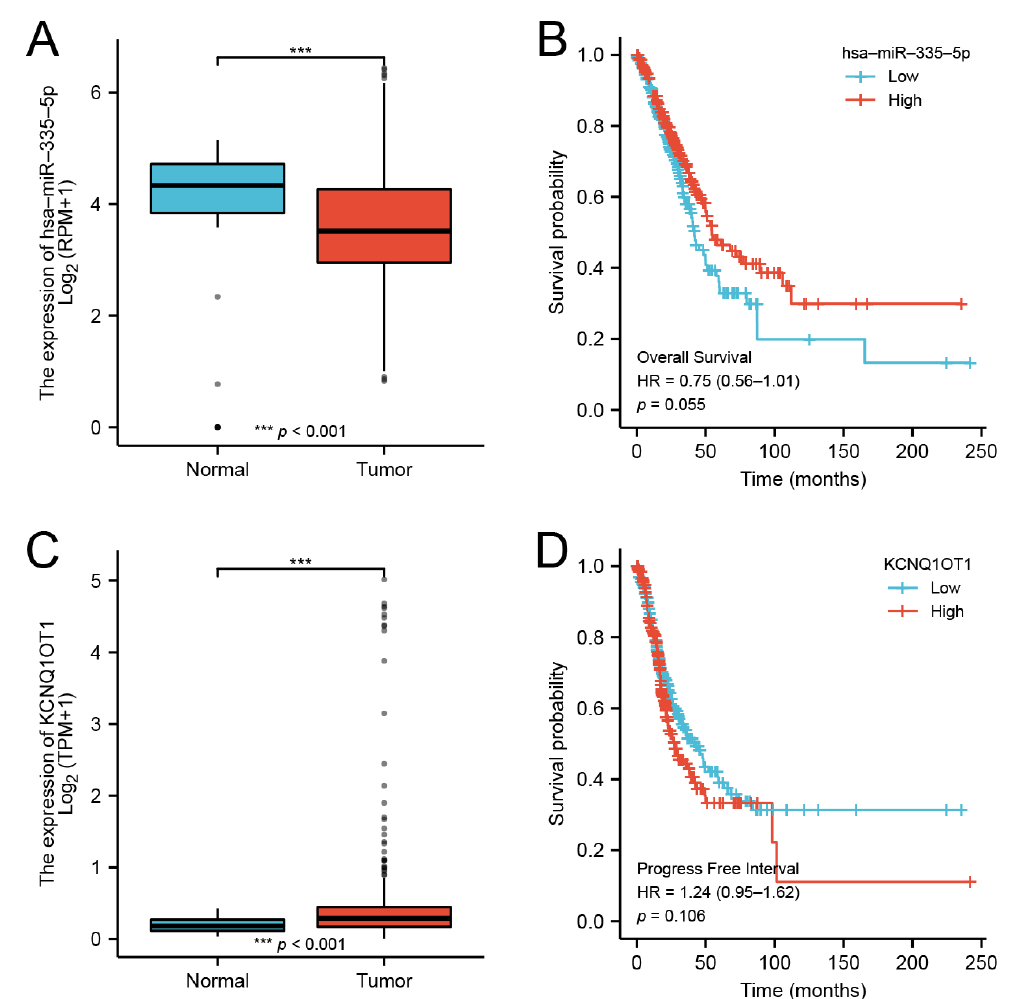
Figure 11. Expression and prognosis of the DMRT3 ceRNA network in LUAD. ( A ) Expression of the miR-335-5p in LUAD and unpaired normal tissues. ( B ) Prognosis of the miR-335-5p in LUAD. ( C ) Expression of the KCNQ1OT1 in LUAD and unpaired normal tissues. ( D ) Prognosis of the KCNQ1OT1 in LUAD.